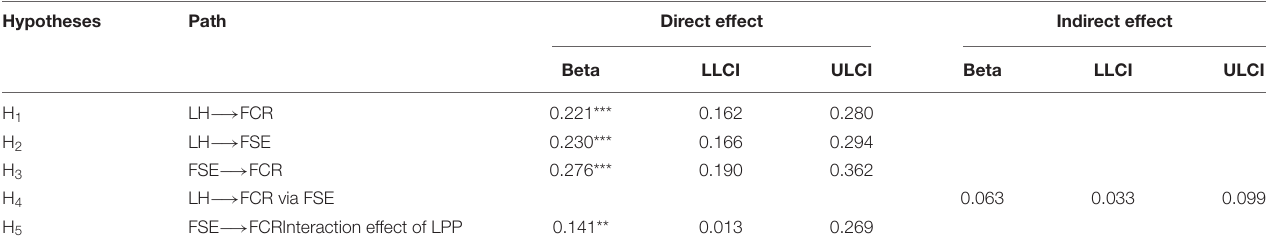
TABLE 4 | Process macros